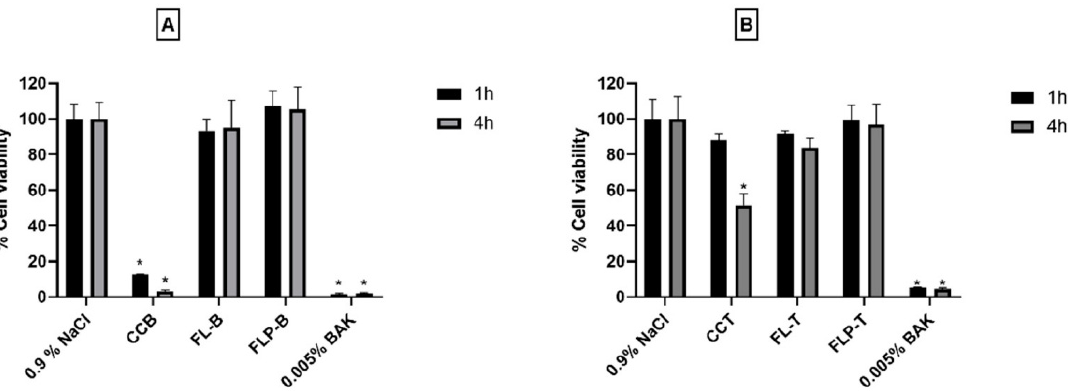
Figure 2. In vitro toxicity evaluation in human corneal hTERT-HCECs cells of liposomal formulations containing brimonidine (FL-B and FLP-B) ( A ) or travoprost (FL-T and FLP-T) ( B ) after 1 and 4 h exposure. FL-B: Brimonidine 0.2%, DOPC 7.5 mg/mL, DMPC 2.5 mg/mL, vitamin E 0.1 mg/mL Ubiquinol 0.025 mg/mL, Taurine 0.5%, Ribitol 0.5%; FLP-B: Brimonidine 0.2%, DOPC 7.5 mg/mL, DMPC 2.5 mg/mL, Vitamin E 0.1 mg/mL Ubiquinol 0.025 mg/mL, Taurine 0.5%, Ribitol 0.5%, HPMC 0.2%. FL-T: 40 µ g/mL, DOPC 7.5 mg/mL, DMPC 2.5 mg/mL, vitamin E 0.1 mg/mL Ubiquinol 0.025 mg/mL, Taurine 0.5%, Ribitol 0.5%; FLP-T: Travoprost 40 µ g/mL, DOPC 7.5 mg/mL, DMPC 2.5 mg/mL, vitamin E 0.1 mg/mL Ubiquinol 0.025 mg/mL, Taurine 0.5%, Ribitol 0.5%, HPMC 0.2%. * Statistically significant difference with respect to the negative control ( p < 0.05).